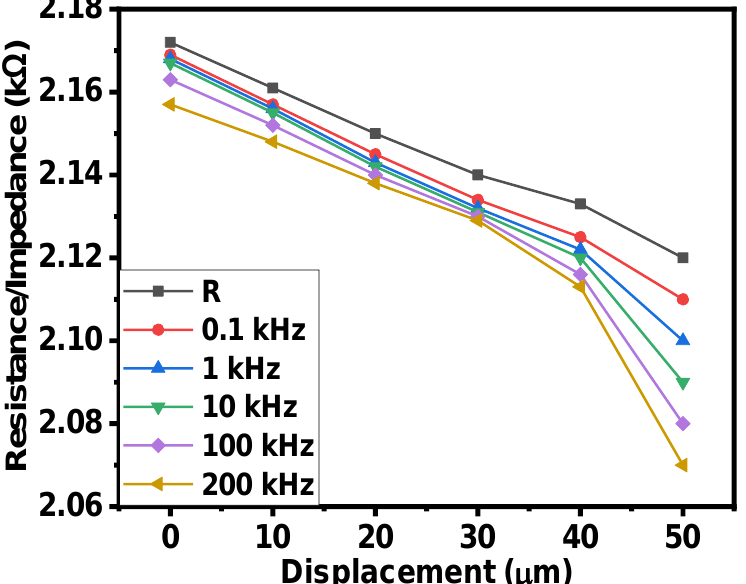
Gels 2022 , 8 , x FOR PEER REVIEW Figure 3. Resistance/impedance – compressive displacement relationships of the surface-type shock- Figure 3. Resistance/impedance–compressive displacement relationships of the surface-type shock- proof resistor based on NiPc – oil jelly and CNT – oil jelly rubber composite. proof resistor based on NiPc–oil jelly and CNT–oil jelly rubber composite.